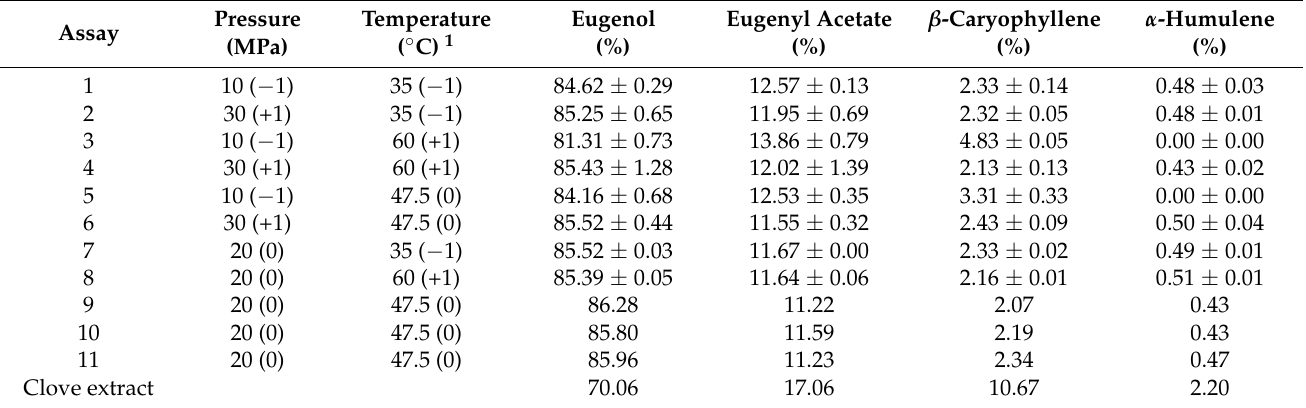
Table 3. Compositions of the extracts impregnated into PC and the crude clove extract, shown as percentage weight for each compound.